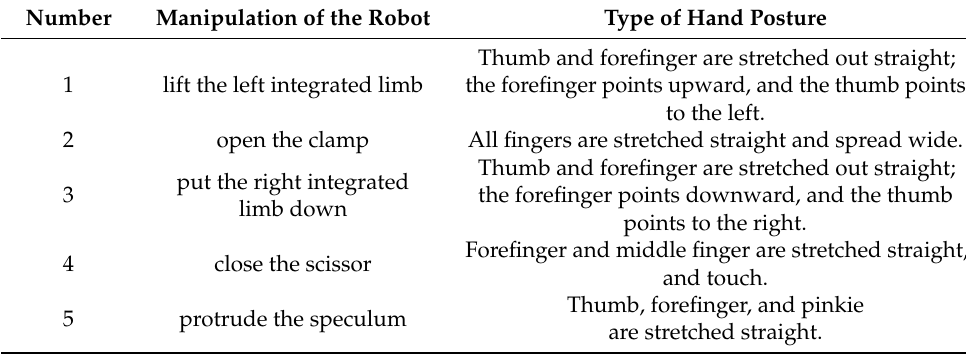
Table 1. Mapping manipulations of the hexapod robot.